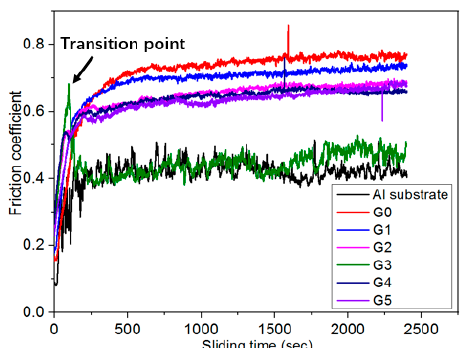
Figure 13. Friction coefficient of the substrate and the coatings with different concentrations of graphene.